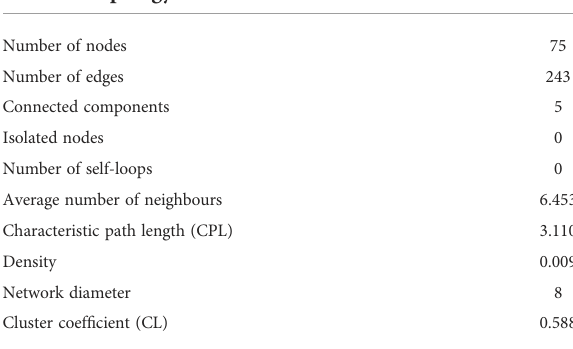
TABLE 2 Topology of the co-occurrence network. Spearman r >